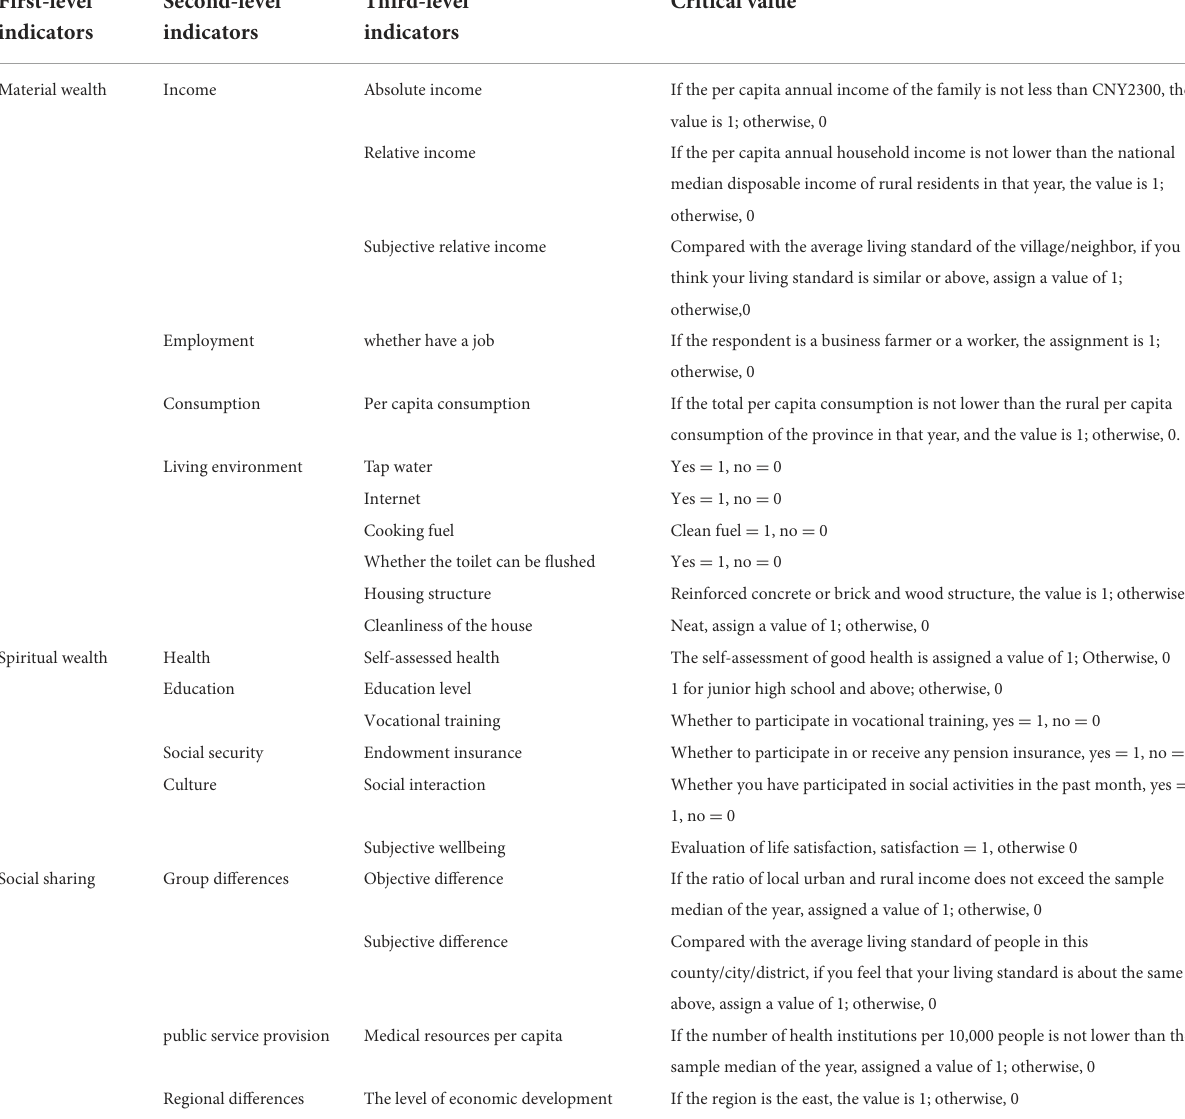
TABLE 1 Common prosperity index system for middle-aged and elderly people in rural